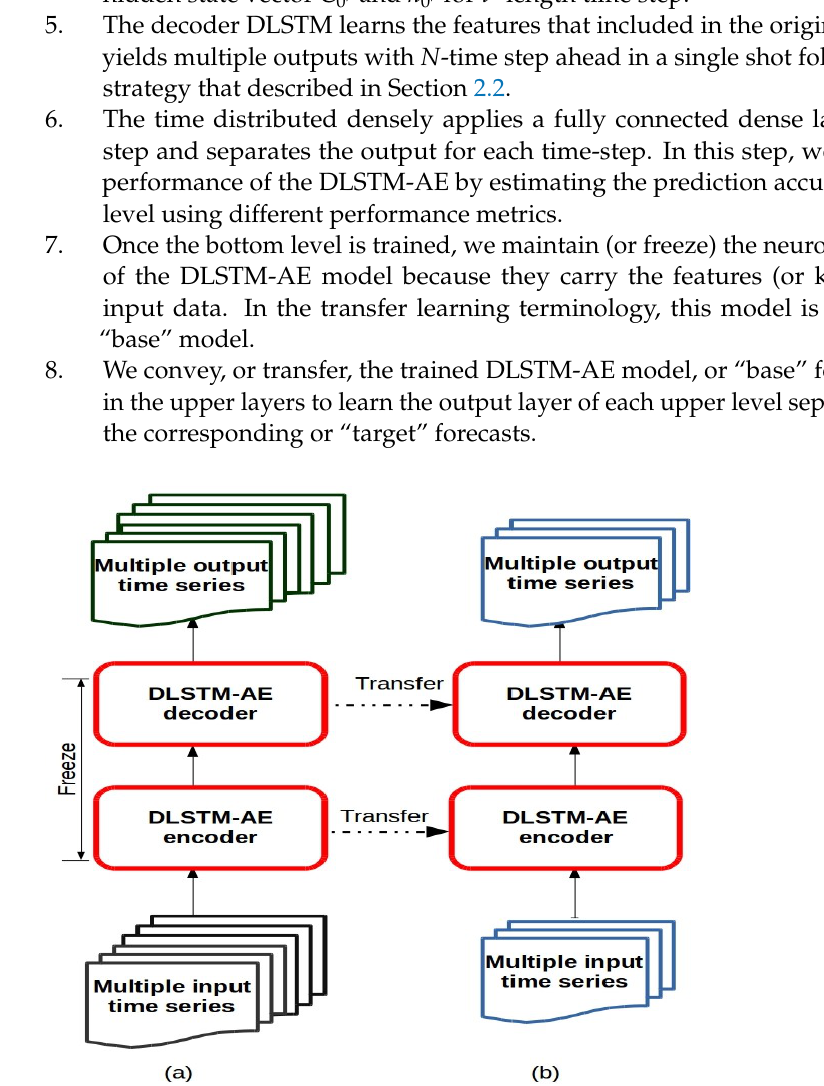
Figure 6. The DLSTM-AE model for ( a ) the bottom level ( b ) the upper